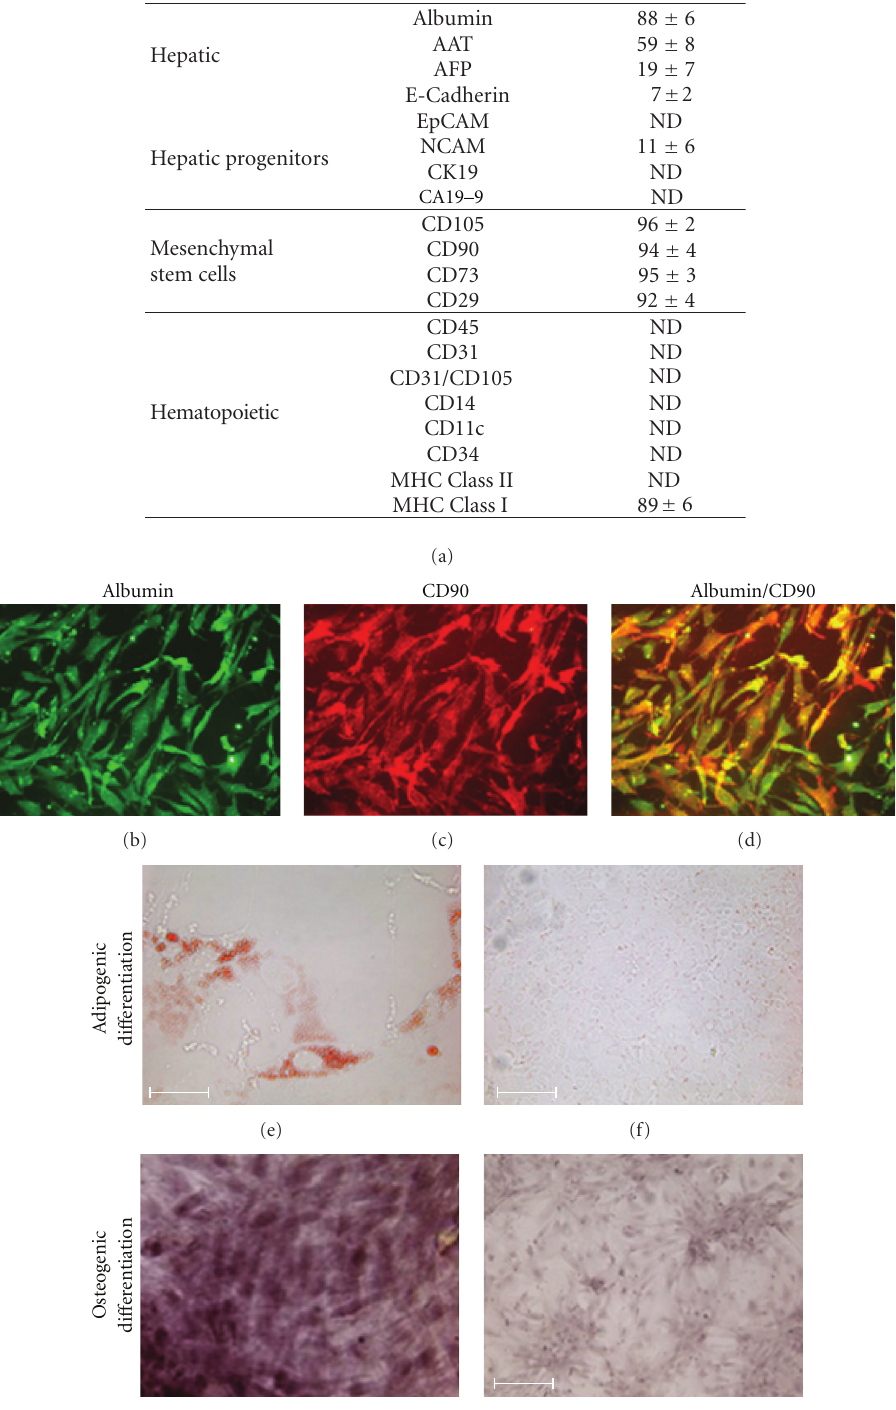
Figure 2: Primary adult human liver cell cultures express hepatic and mesenchymal stem-cell markers and di ff erentiate along adipogenic and osteogenic lineages. (a) Adult human liver cells (P1–P7, n ≥ 5) were characterized for the expression of specific surface and intracellular markers of hepatic, hepatic progenitor, mesenchymal, and hematopoietic lineages by flow cytometry. (b–d) Double immunofluorescent staining of human liver cells (P7) for albumin and CD90. Nuclei were stained by DAPI (blue). Original magnification × 20. (e) Liver cells at P4 were induced to di ff erentiate toward the adipogenic and (g) osteogenic lineages using the specific di ff erentiation cocktails for 21 days in culture. Control cells in regular cell culture media are shown in (f) and (h). Samples were fixed and stained with Oil Red (adipogenic lipids, (e), (f) or Alizarin (osteogenic calcium, (g), (h)). Original magnification ×